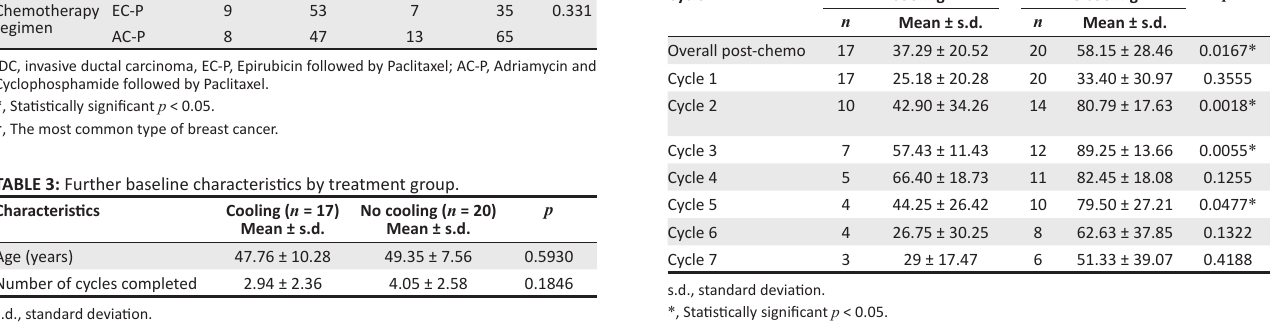
TABLE 5: Comparative chemotherapy-induced alopecia through each cycle of treatment in the cooling versus non-cooling groups. Cycle